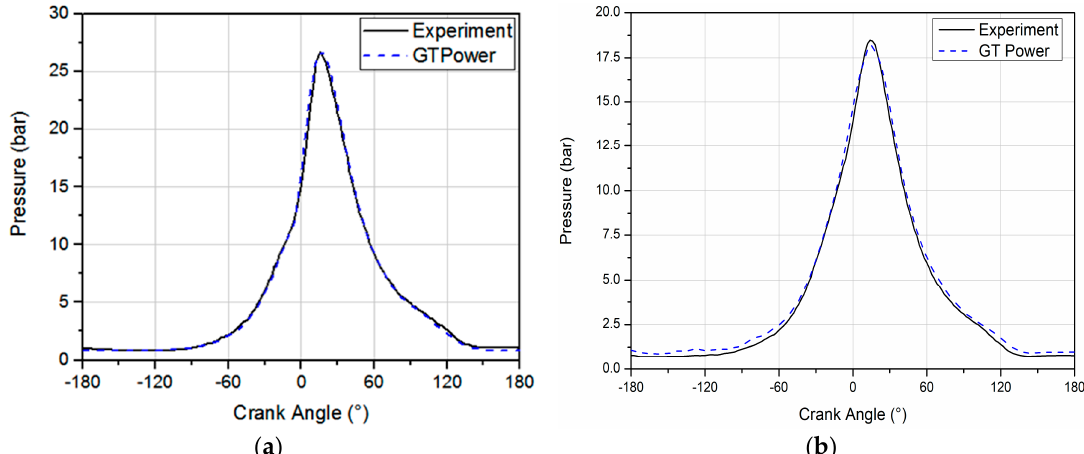
Figure 5. Comparison of in-cylinder pressure curves between the experiment and GT Power simulation. ( a ) High load operating condition; ( b ) partial load operating condition.